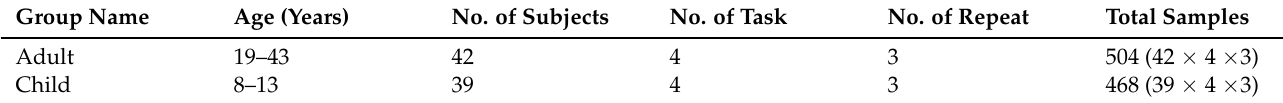
Table 2. Summary of the handwritten pattern dataset.